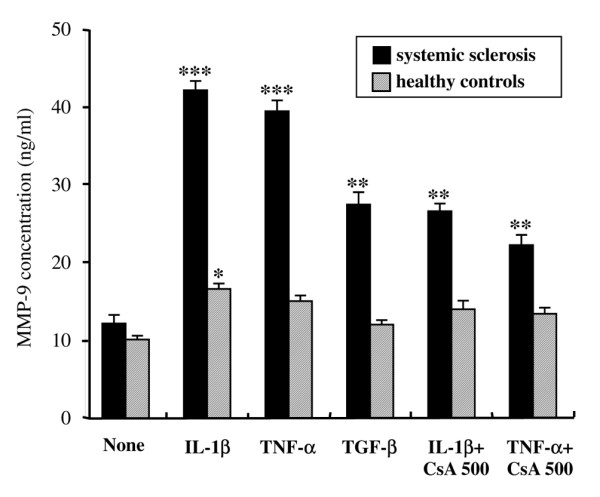
The production of matrix metalloproteinase-9 (MMP-9) and tissue inhibitor of metalloproteinase-1 (TIMP-1) from cultured dermal fibroblasts. Dermal fibroblasts were obtained from affected skin of two patients with systemic sclerosis (SSc) and two healthy controls. Second- or third-passage fibroblasts (5 × 104 cells) were cultured for 24 hours in Dulbecco's modified Eagle's medium alone and in the presence of IL-1β (10 ng/ml), tumor necrosis factor (TNF)-α (10 ng/ml), transforming growth factor β (TGFβ) (10 ng/ml), IL-1β (10 ng/ml) plus cyclosporin A (CsA) (500 ng/ml), or TNF-α (10 ng/ml) plus CsA (500 ng/ml). The concentrations of MMP-9 in the supernatants were determined by ELISA. Data are expressed as means ± standard error of the mean (SEM) of two independent experiments performed in triplicate using different cell lines. *P < 0.05, **P < 0.01, ***P < 0.001 versus medium alone (Mann–Whitney rank sum test).